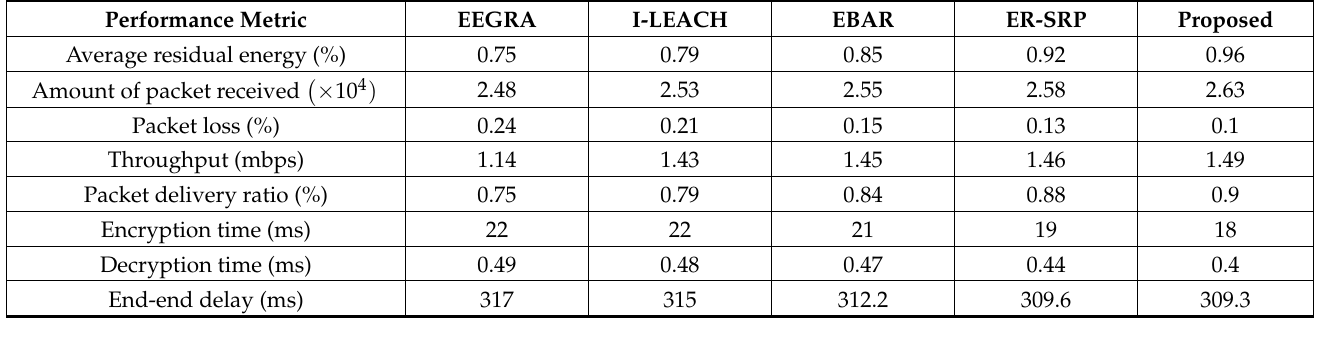
Table 4. Metrics evaluated for the proposed and existing routing protocol.